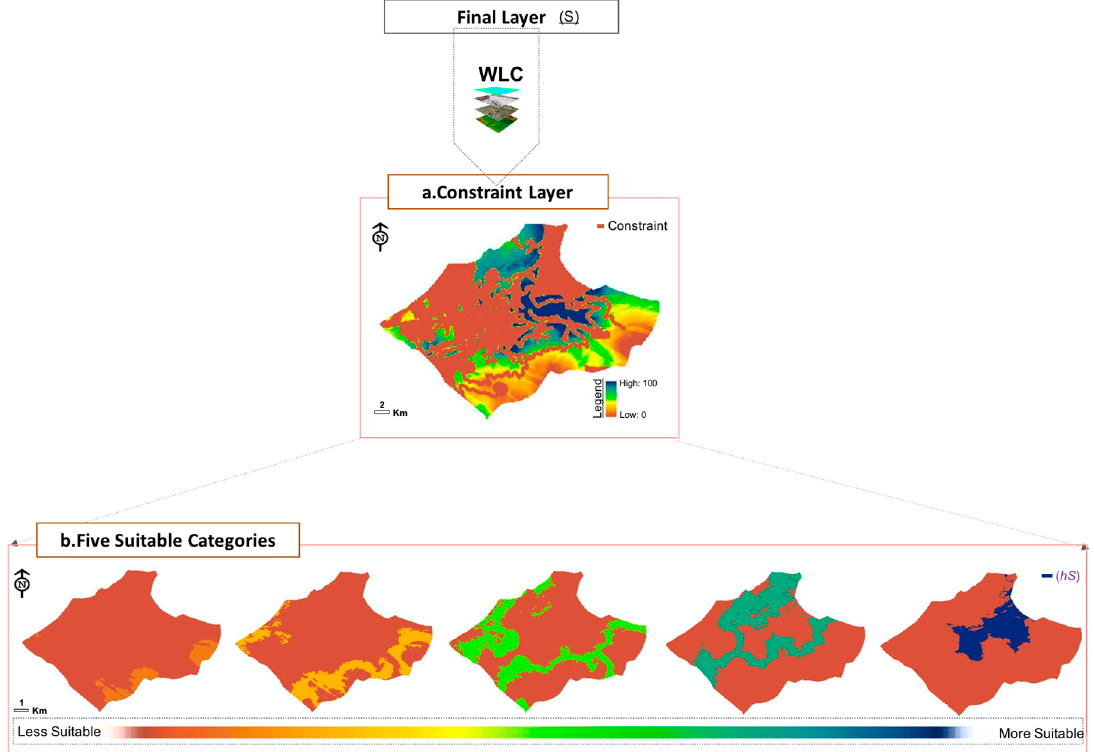
Figure 6. Constraints and five categorical values of final suitability map (S) with multicriteria GIS-MCDA evaluation: ( a ) Constraint layers and ( b ) Five suitable layers.